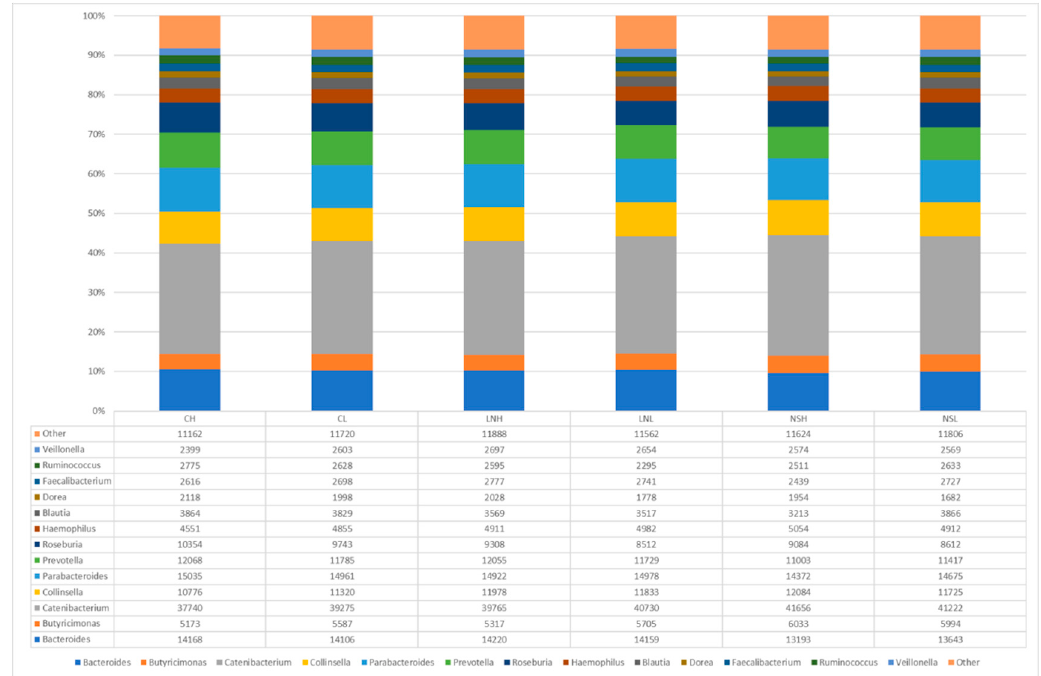
Figure 3. Relative abundance of bacterial genera found in the sequences obtained from 16S rRNA gene-targeted Illumina sequencing. Population codes follow Figure 1. The category “Other” ( < 4%) includes Haemophilus, Blautia, Ruminococcus, Faecalibacterium, Veillonella, and